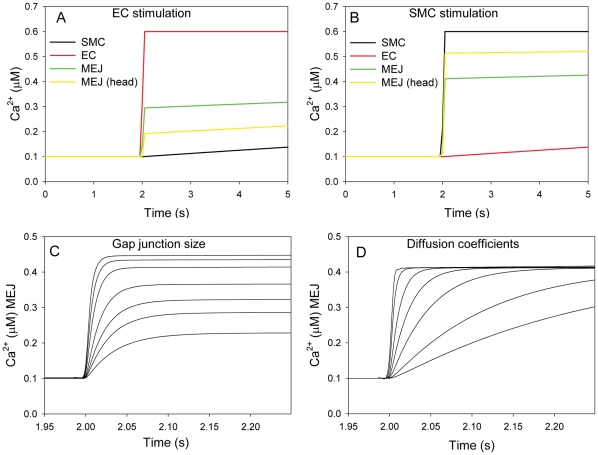
Model 1, diffusion through the MEJ.The effect of the MEJ on diffusion between the SMC and EC was tested by increasing the Ca2+ concentration in A): EC from 0.1 µM to 0.6 µM and B): in the SMC from 0.1 µM to 0.6 µM at time 2 s. The average concentration in the EC, the SMC, the MEJ and only in the head of the MEJ is shown in both cases. C) Average Ca2+ concentrations in the MEJ as a function of gap junction pore size. From below pore size was: 10, 20, 30, 50, 100, 150 and 200 nm. D) The diffusion coefficient was changed within a chemical/biological realistic regime and the average Ca2+ concentration in the MEJ was found for each value. From below 10, 20, 50, 100, 200, 500 and 1000 µm2/s.